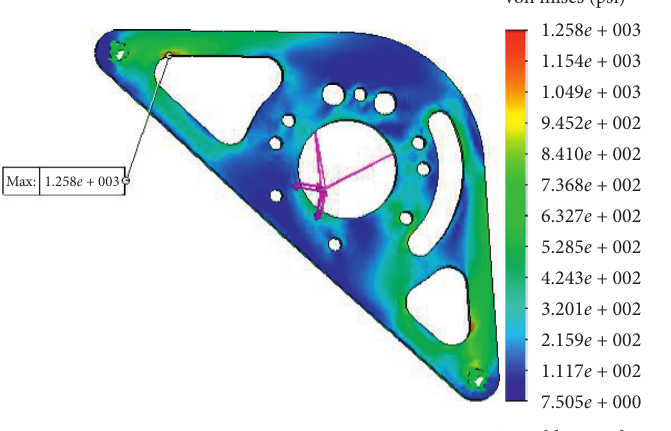
Figure 5: FEA for the right motor mount with a minimum factor of safety of 10.1.